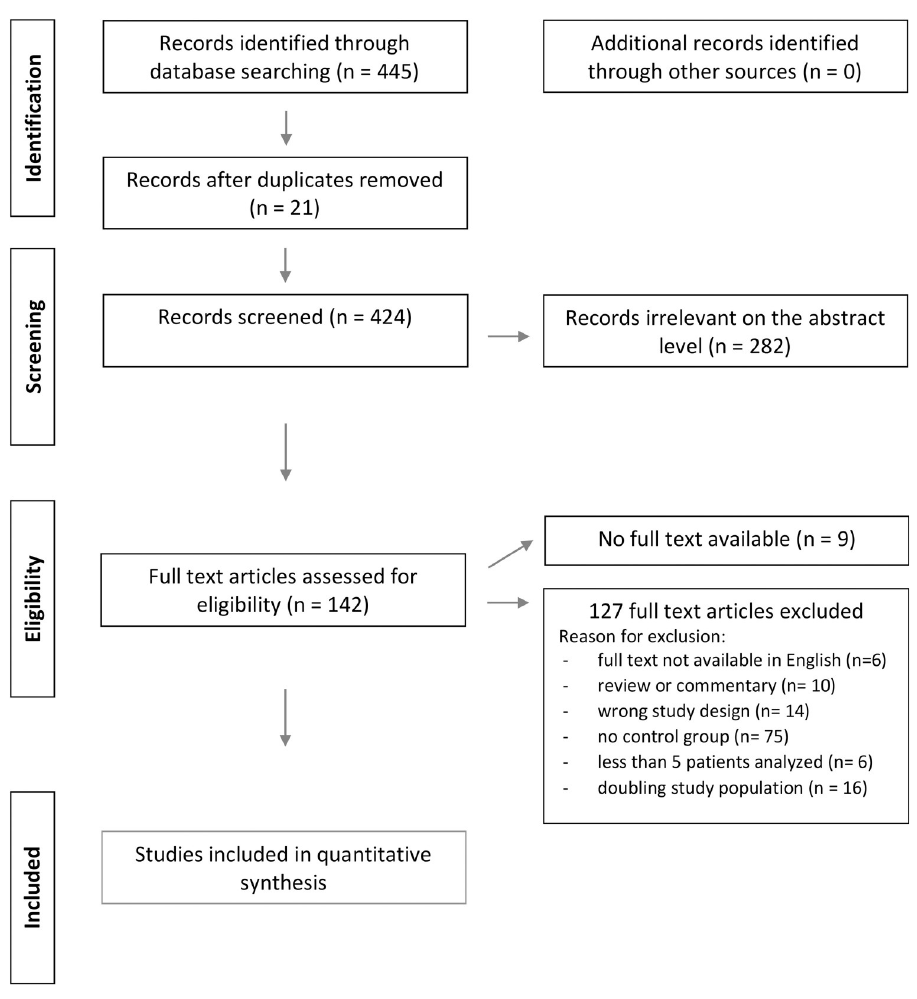
Fig 1. Prisma flow